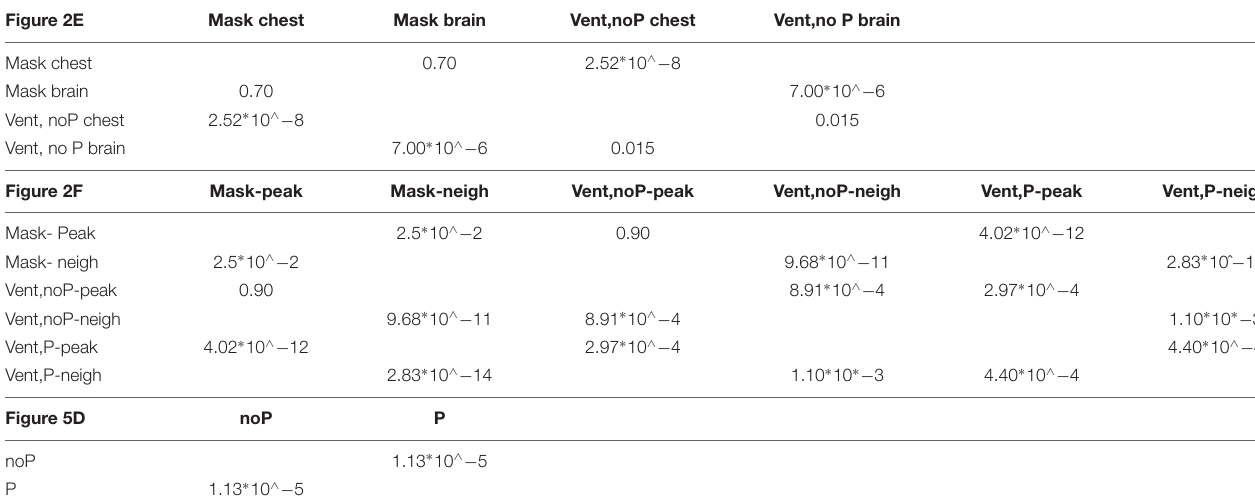
TABLE 2 | p -values.